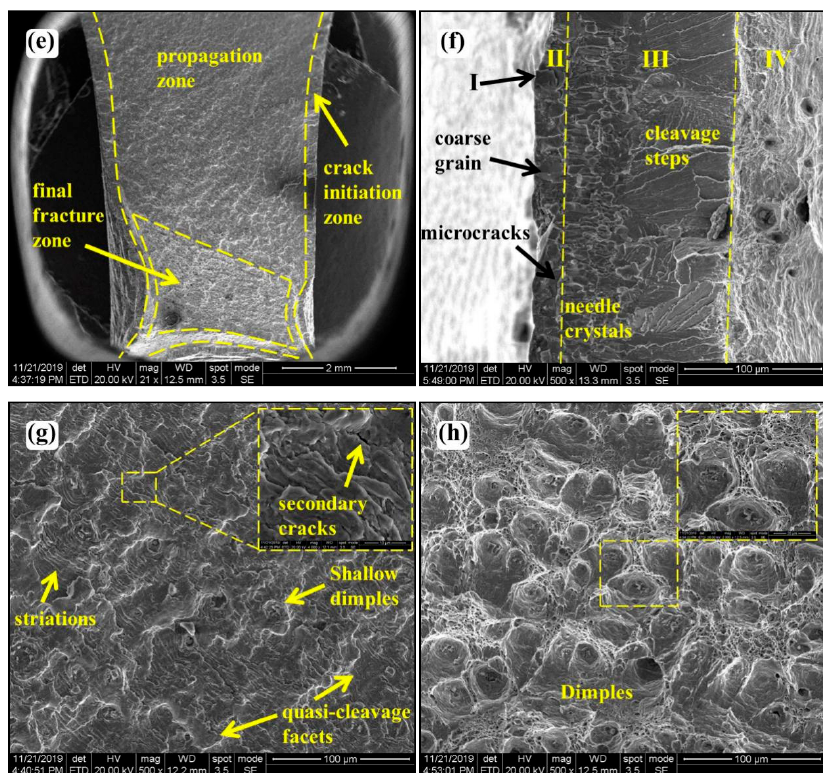
Figure 10. SEM micrograph of low-cycle fatigue morphology at the strain amplitude of 0.3%: ( a ) the global view of as-received steel; ( b ) crack initiation zone of as-received steel; ( c ) crack propagation zone of as-received steel; ( d ) final fracture zone of as-received steel; ( e ) the global view of aluminized steel; ( f ) crack initiation zone of aluminized steel; ( g ) crack propagation zone of aluminized steel; ( h )